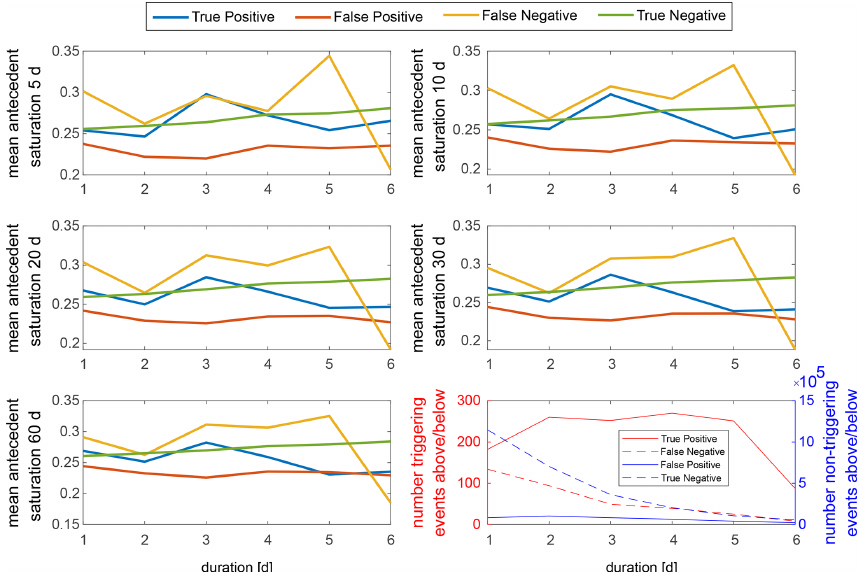
Figure 6. Plots of mean antecedent soil saturation averaged over 5, 10, 20, 30, and 60d prior to the beginning of the corresponding rainfall event for durations of 1–6d. Events are divided into four groups: true positive (TP, triggering events above the threshold), false positive (FP, non-triggering events above the threshold, also called false alarms), false negative (FN, triggering events below the threshold, also called misses), and true negative (TN, non-triggering events below the threshold). The plot in the lower right shows the number of events in each group of events for each duration, to check the robustness of the mean estimates.